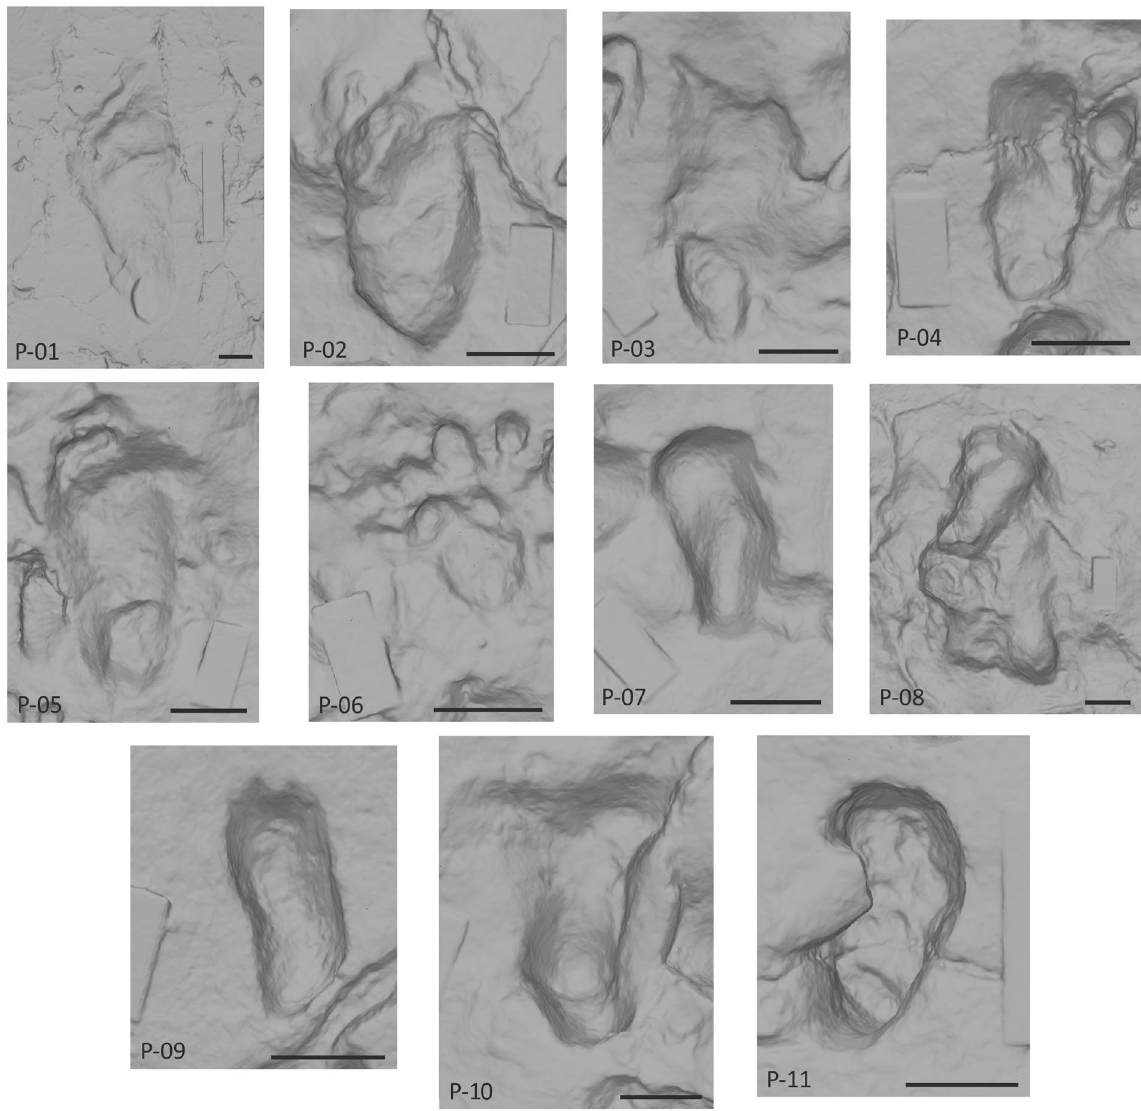
Figure 5. 3D models of the hominin tracks. The scale bar is 50 mm (see Table 1 for dimensions). Models were made from oblique digital photographs in Agisoft